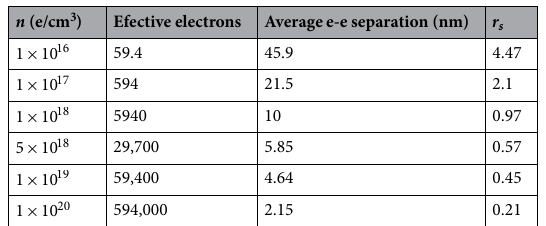
Table 1. Wigner–Seitz ratio ( r s ) and related parameters for a Y-J of L z = 2 µ m and L x , y = 25 nm.